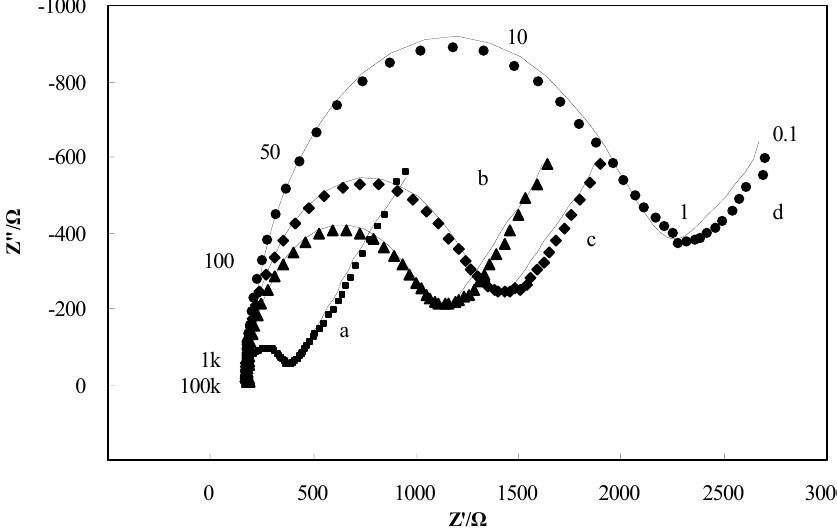
, solution resistance; CPE , constant S